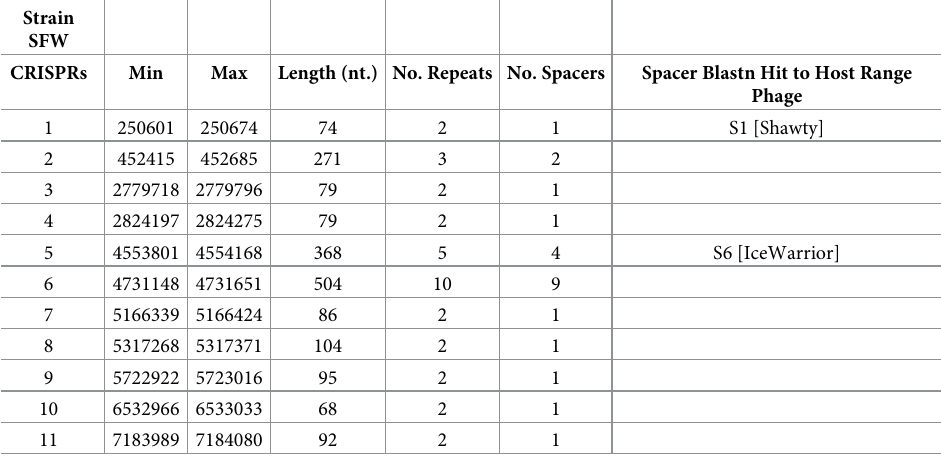
Length (nt.) No. Repeats No.